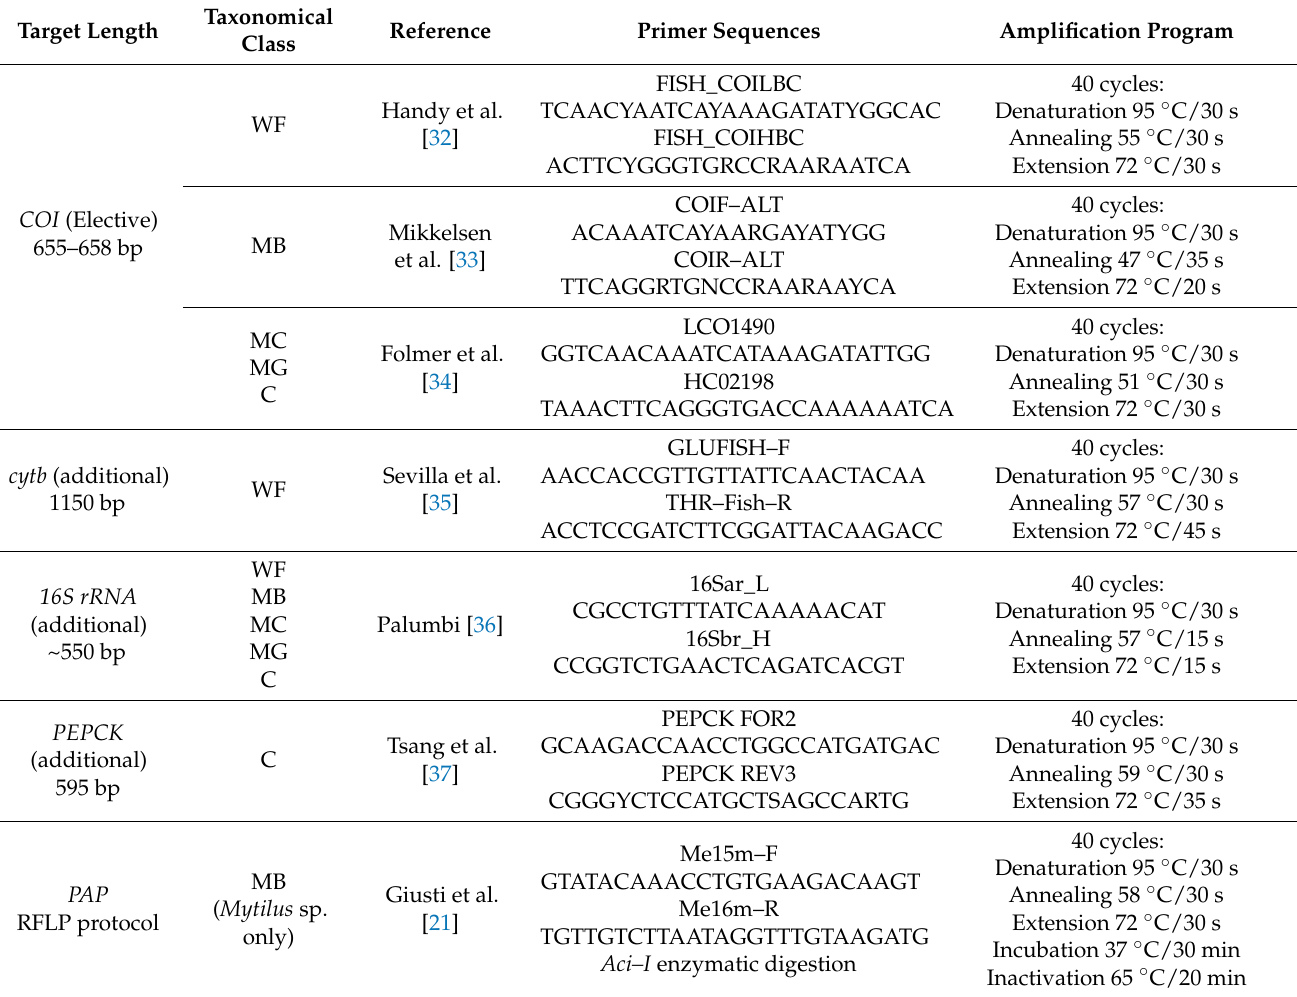
Table 1. Molecular targets selected in this study, primers pairs and amplification protocol